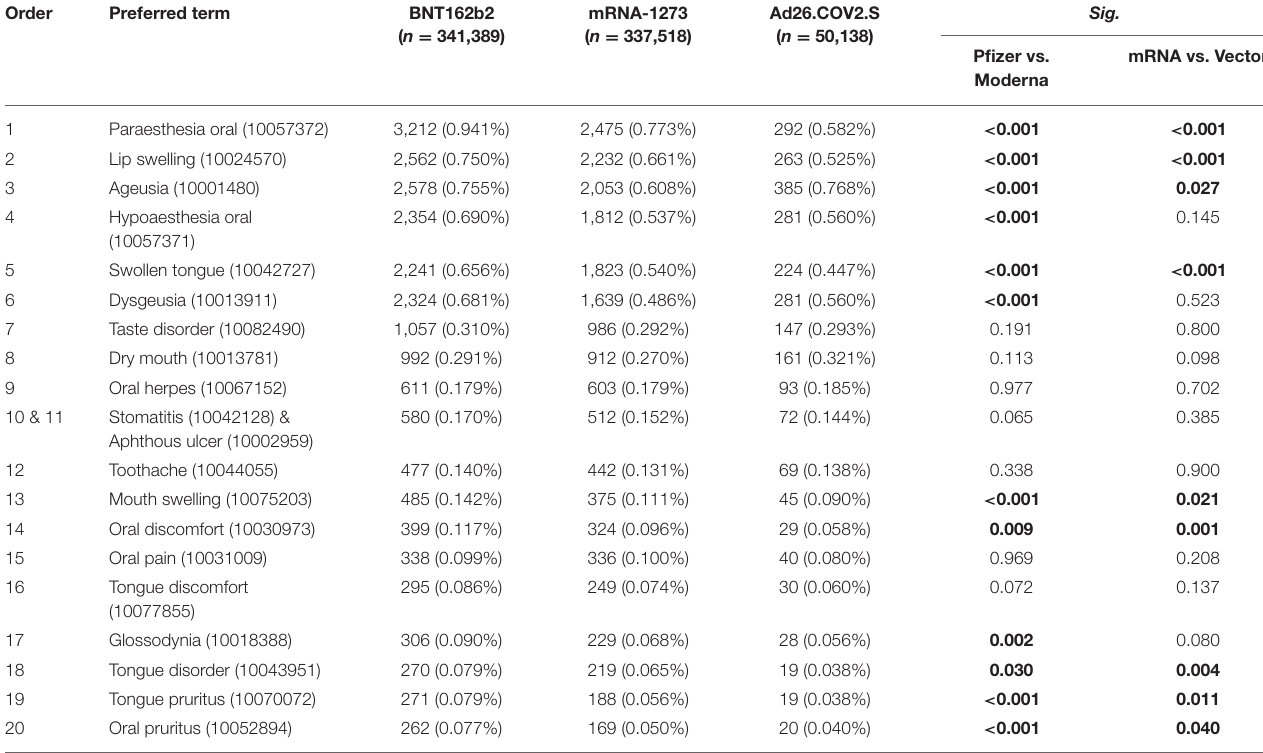
TABLE 5 | Top twenty oral adverse events reported after COVID-19 vaccines in the United States stratified by vaccine type, January–December 2021 (CDC; VAERS-WONDER). Order